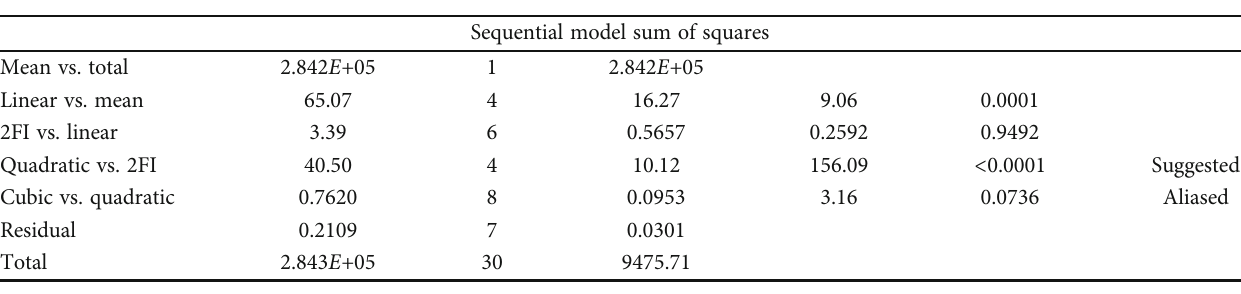
Table 5: Model summary statistics and sequential model sum of squares for CEX by nanoparticles. (a)